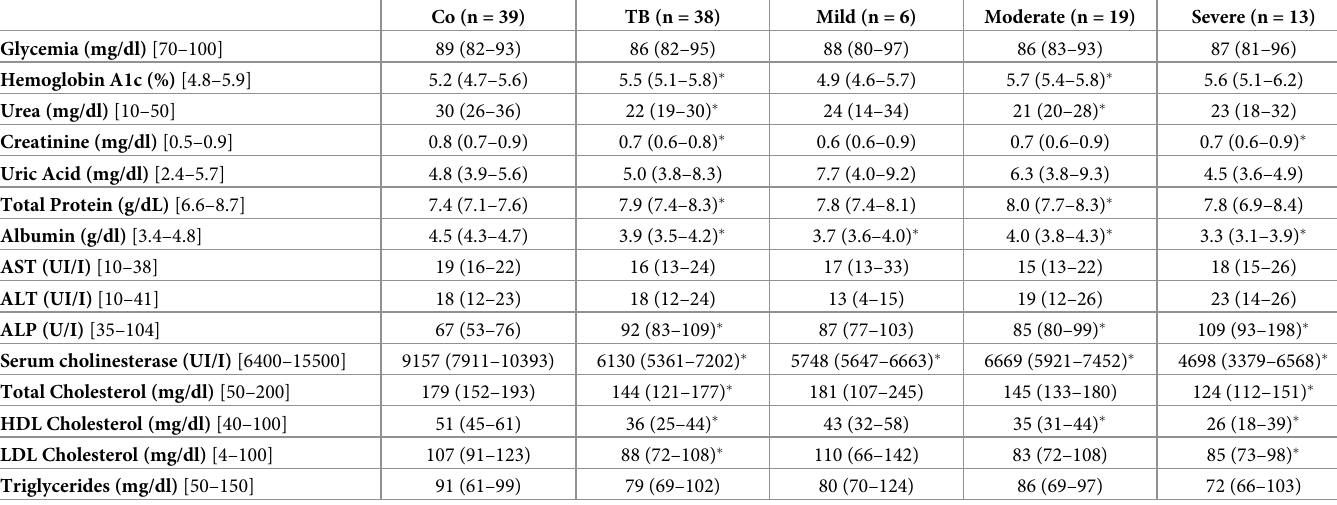
Table 4. Blood biochemical